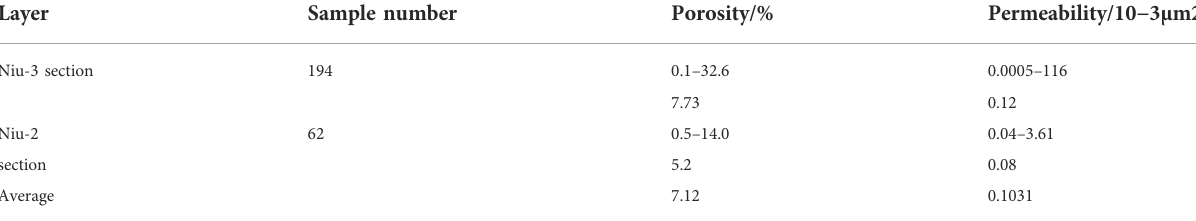
TABLE 3 Statistical of the physical properties of drilling reservoirs in the lumpura